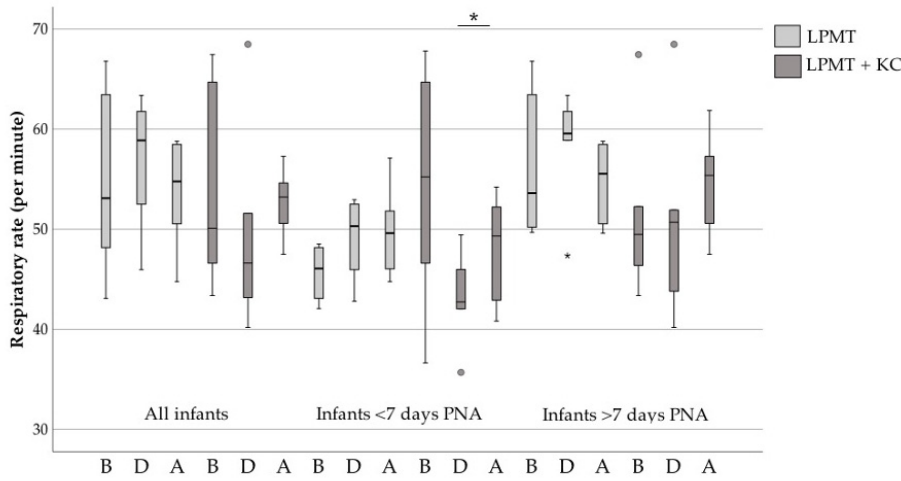
Figure 2. Respiratory rate before, during and after LPMT compared with combined interventions. The boxes represent the interquartile ranges and the whiskers represent the range of all infants. Grey points and stars indicate the outliers of this study. PNA, postnatal age; LPMT, live-performed music therapy; KC, kangaroo care; B, before therapy; D, during therapy; A, after therapy; *, p < 0.05.